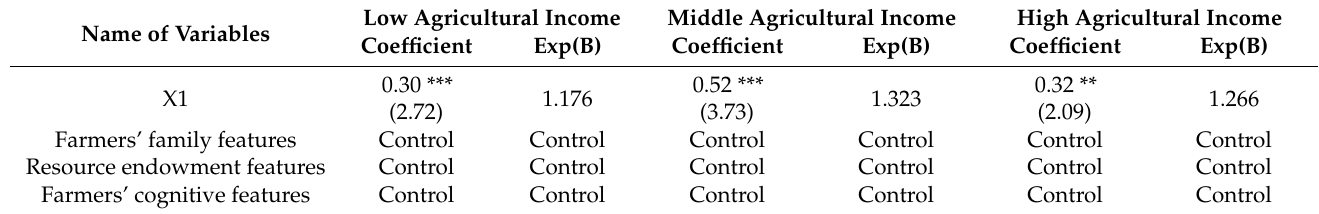
Table 5. Results of model fitting for various agricultural income